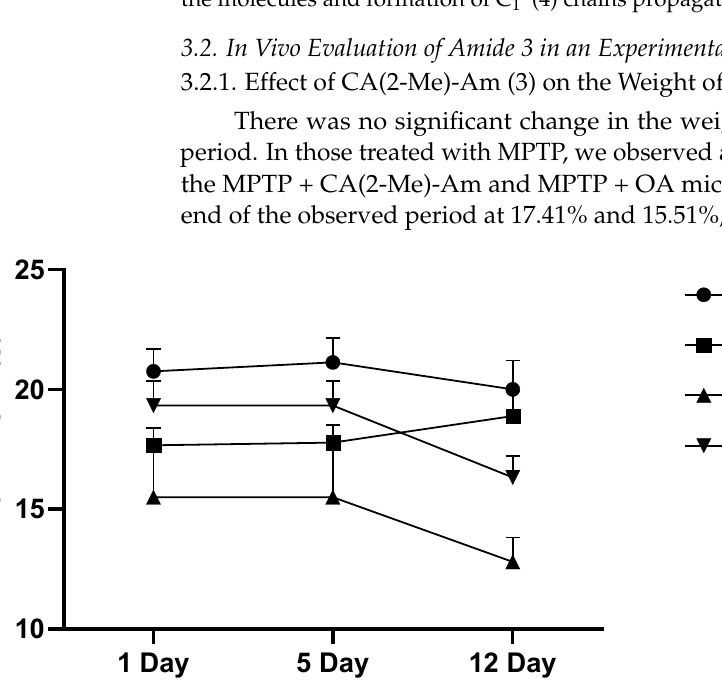
Figure 2. The observed ( a ) hydrogen bonding interaction stabilizing the crystal structure of ( E )– N -(2-methylcinnamoyl)-amantadine and ( b ) a view along the b axis of the three-dimensional packing of the molecules and formation of C 11 (4) chains propagating along the [010] plane.